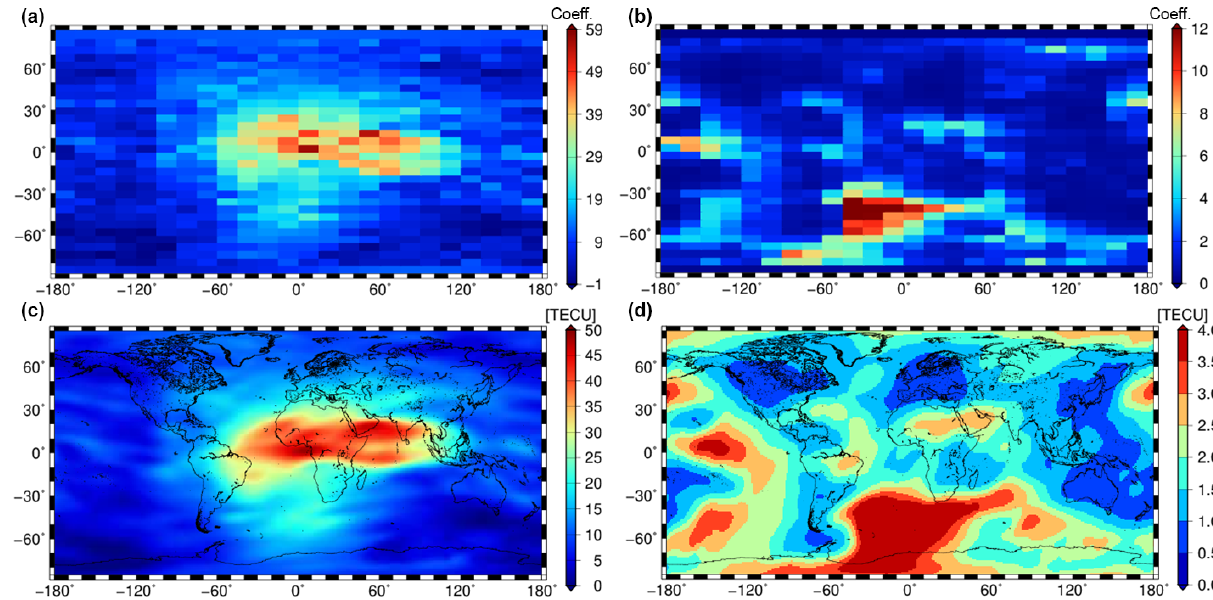
Figure 8. Estimated scaling coefficients (a) and their standard deviations (b) for level values J 1 = 5 and J 2 = 3 within the GSM coordinate system. Estimated VTEC values (c) and their standard deviations (d) as GIMs within a geographical coordinate system; all sets calculated for 6 September 2017 at